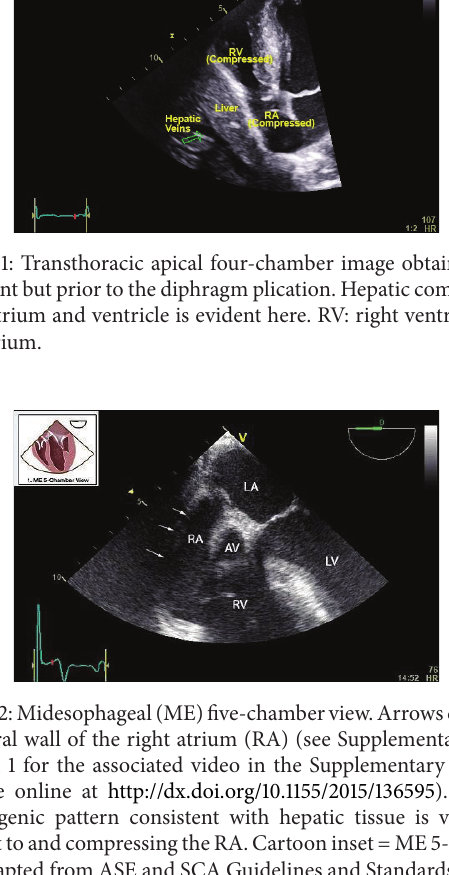
for position-related compression of the heart. Compression